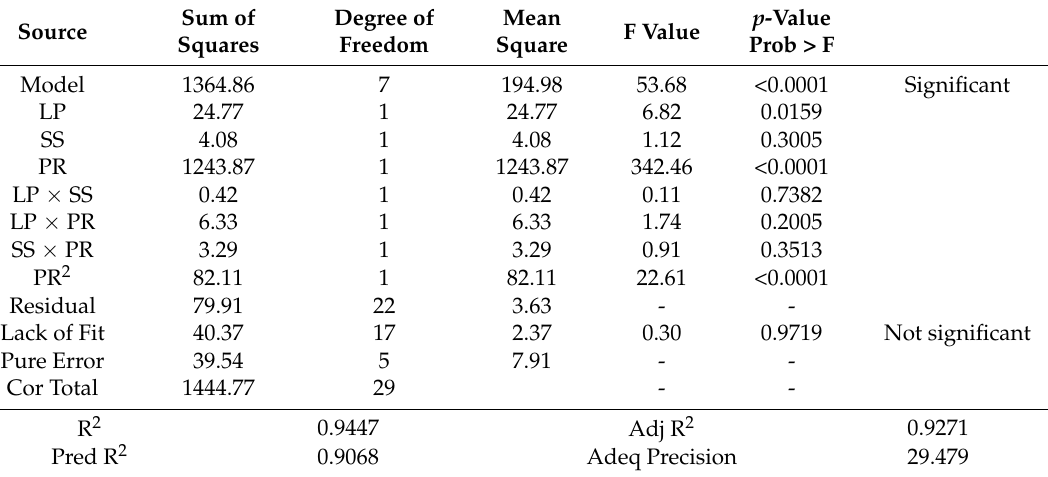
Table 5. Analysis of variance on micro-hardness.